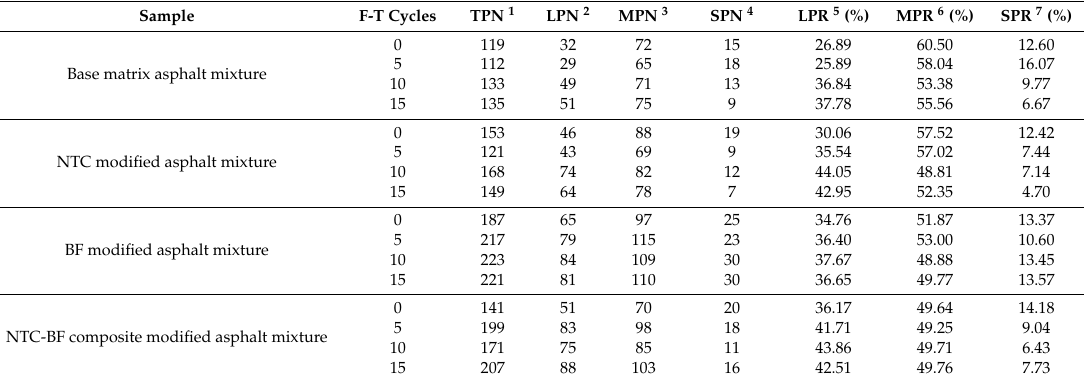
Table 6. The void numbers of asphalt mixtures under F–T cycles.